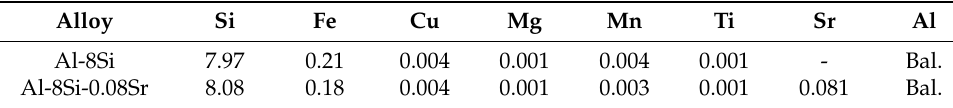
Table 1. Chemical compositions of Al-8Si alloys